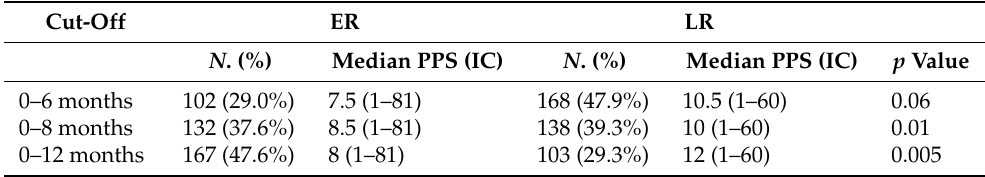
Table 2. Evaluated cut-off thresholds for defining ER and LR based on the PPS after